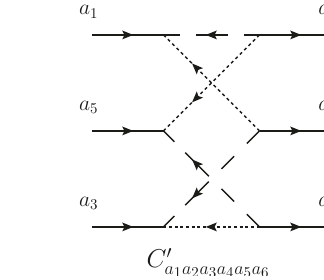
Table 2 . Theory dependent coe(cid:14)cients determining the two-loop (cid:16) (3) contribution to the scaling functions F ((cid:1)) for the two towers with (cid:1) = 2 ; 3.